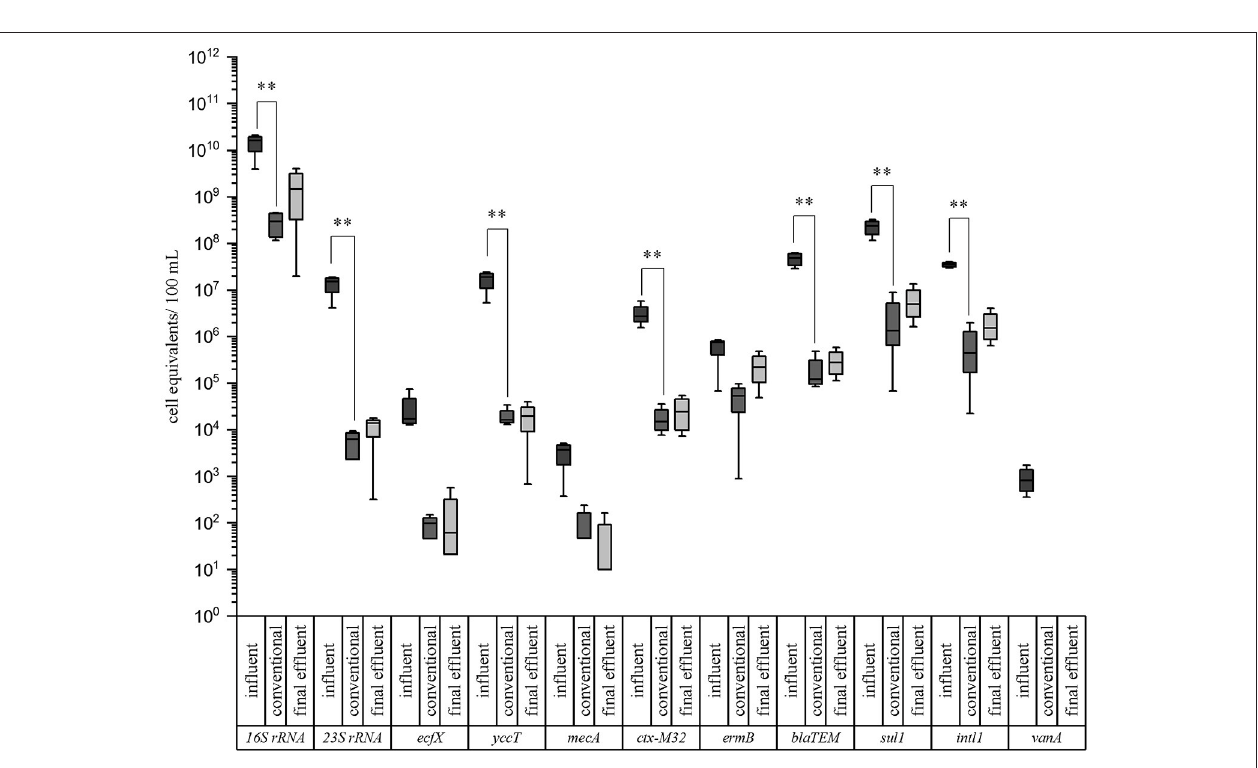
FIGURE 2 | Box plot graphs of the qPCR analyses targeting taxonomic and antibiotic resistance gene markers in wastewater samples of a municipal WWTP. Data are given for the influent, conventional (activated sludge with sedimentation), and effluent samples. Median values, standard deviations, and minimum/maximum values from 4 sampling periods are given. Significance is given by t -test calculation and is shown by asterisks ( t -test; ** p < 0.05, * p <